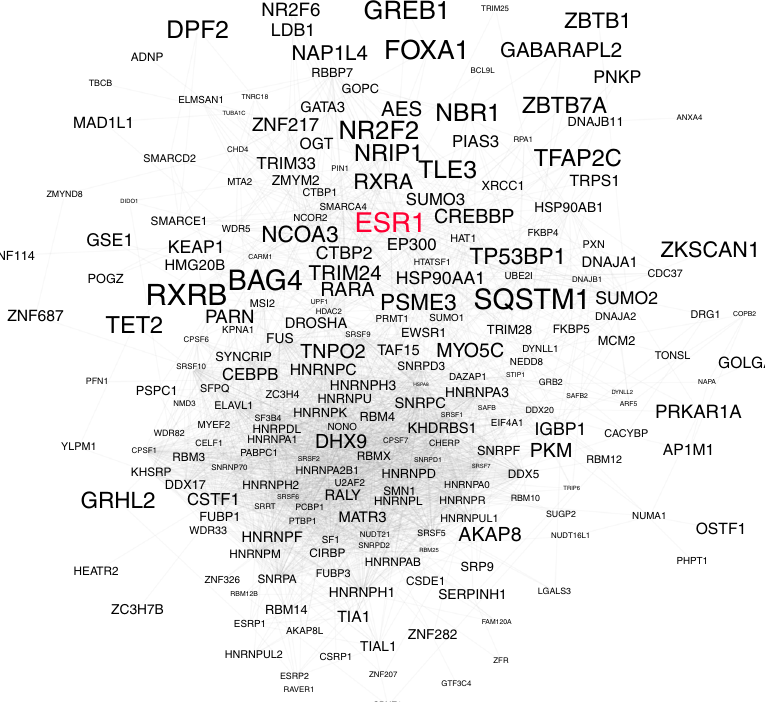
Fig. 7 Most frequently enriched ER α interactors. STRING network of 253 ER α interactors identi fi ed consistently across all the qPLEX-RIME analyses performed in MCF7 cells. The font size increases proportionally to the average fold-change enrichment of these proteins across all the ER α samples compare to IgG